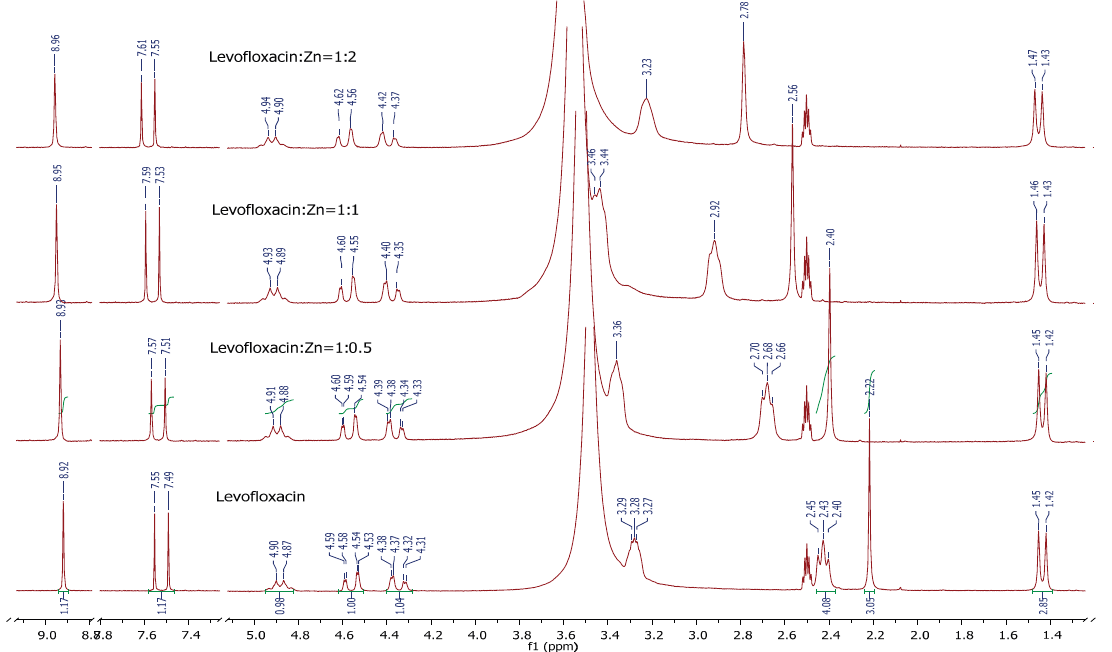
Figure 9. 1 H-NMR spectra of Zn(II)-levofloxacin complexes at various mole ratios of the solution recorded at 200 MHz. ligand and zinc salt in DMSO-d 6